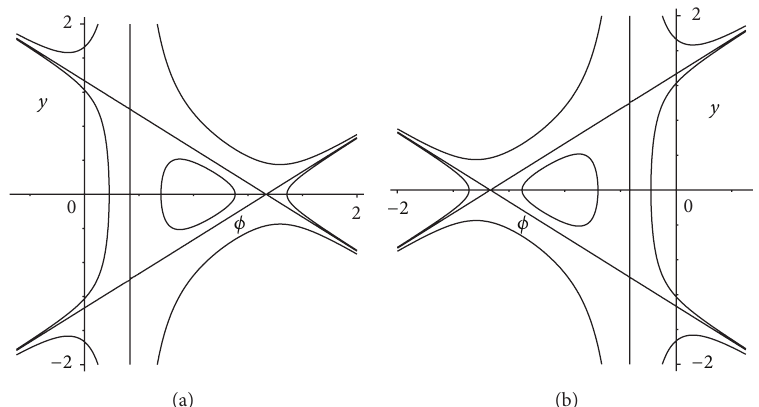
Figure 2: The bifurcation sets and phase portraits of system (13) when 𝑘 = 0 . (a) 𝑐 ∈ 𝐴 1 . (b) 𝑐 ∈ 𝐴 2